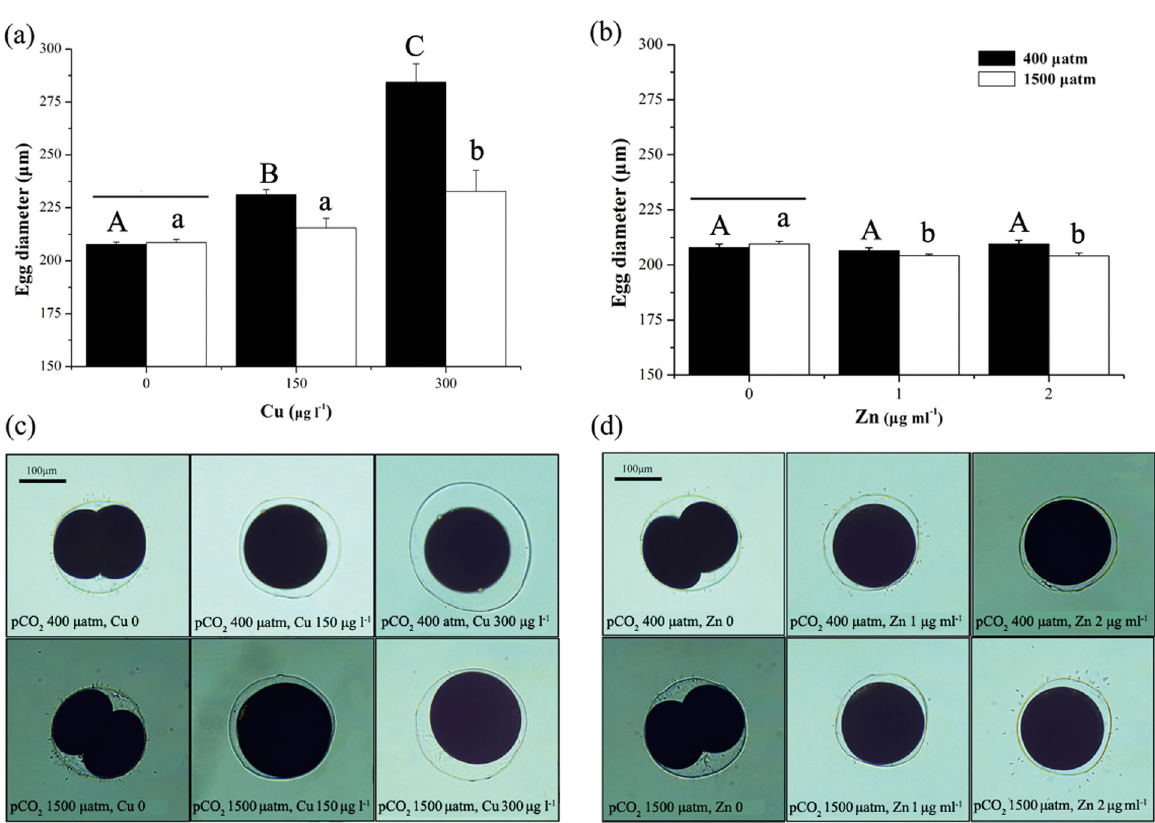
Fig. 4. Egg diameter (mean + SD; n = 4) of Haliotis discus hannai 2 h post fertilization at pCO 2 400 and 1500 µatm with the addition of (a) Cu or (b) Zn. Different upper- and lowercase letters represent significant differences between different trace metal concentrations at the same pCO 2 level (p < 0.05). A line above columns indicates no significant difference between 400 and 1500 µatm at the same trace metal concentration. Columns not connected by lines are significantly different from each other (p < 0.05). Photos showing (c) significant expansion of egg membrane in high Cu concentration treatments at pCO 2 400 µatm but less evident expansion at pCO 2 1500 µatm, and (d) subtle but significant reduction of egg diameter in high Zn concentration treatments at pCO 2 1500